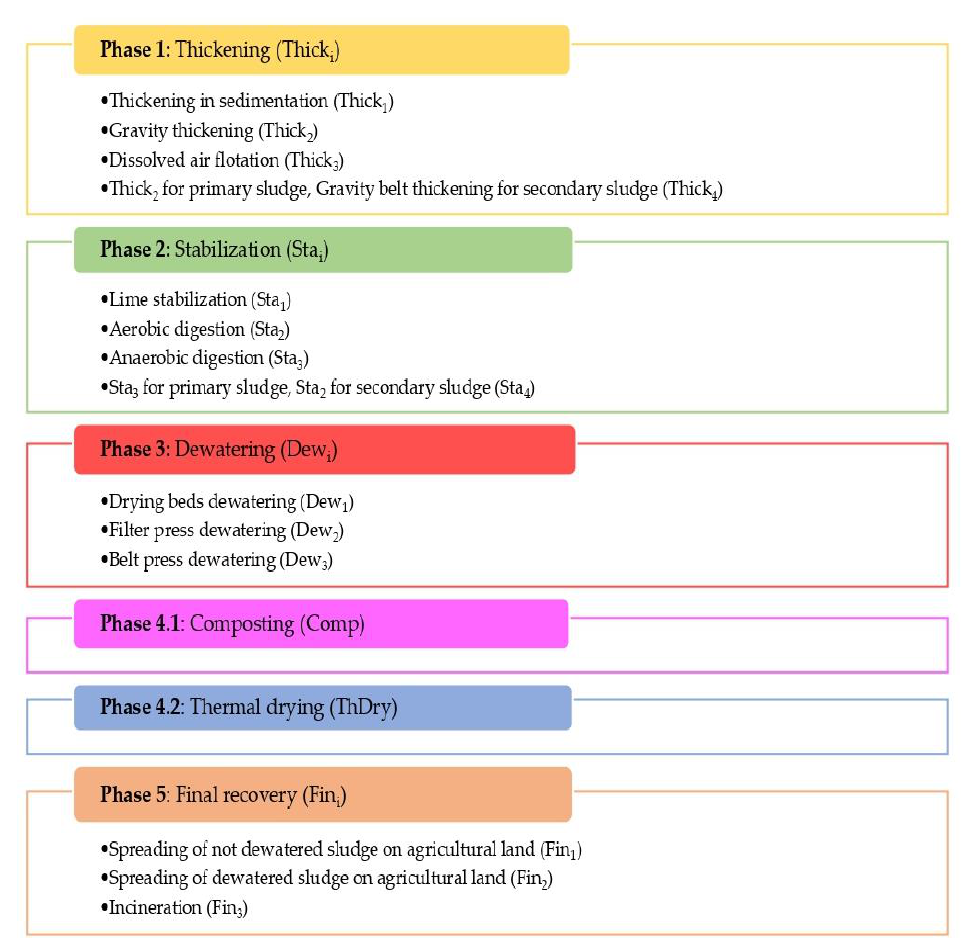
Figure 2. Summary of the alternative technological options considered by the scenario analysis for each SSTS phase.